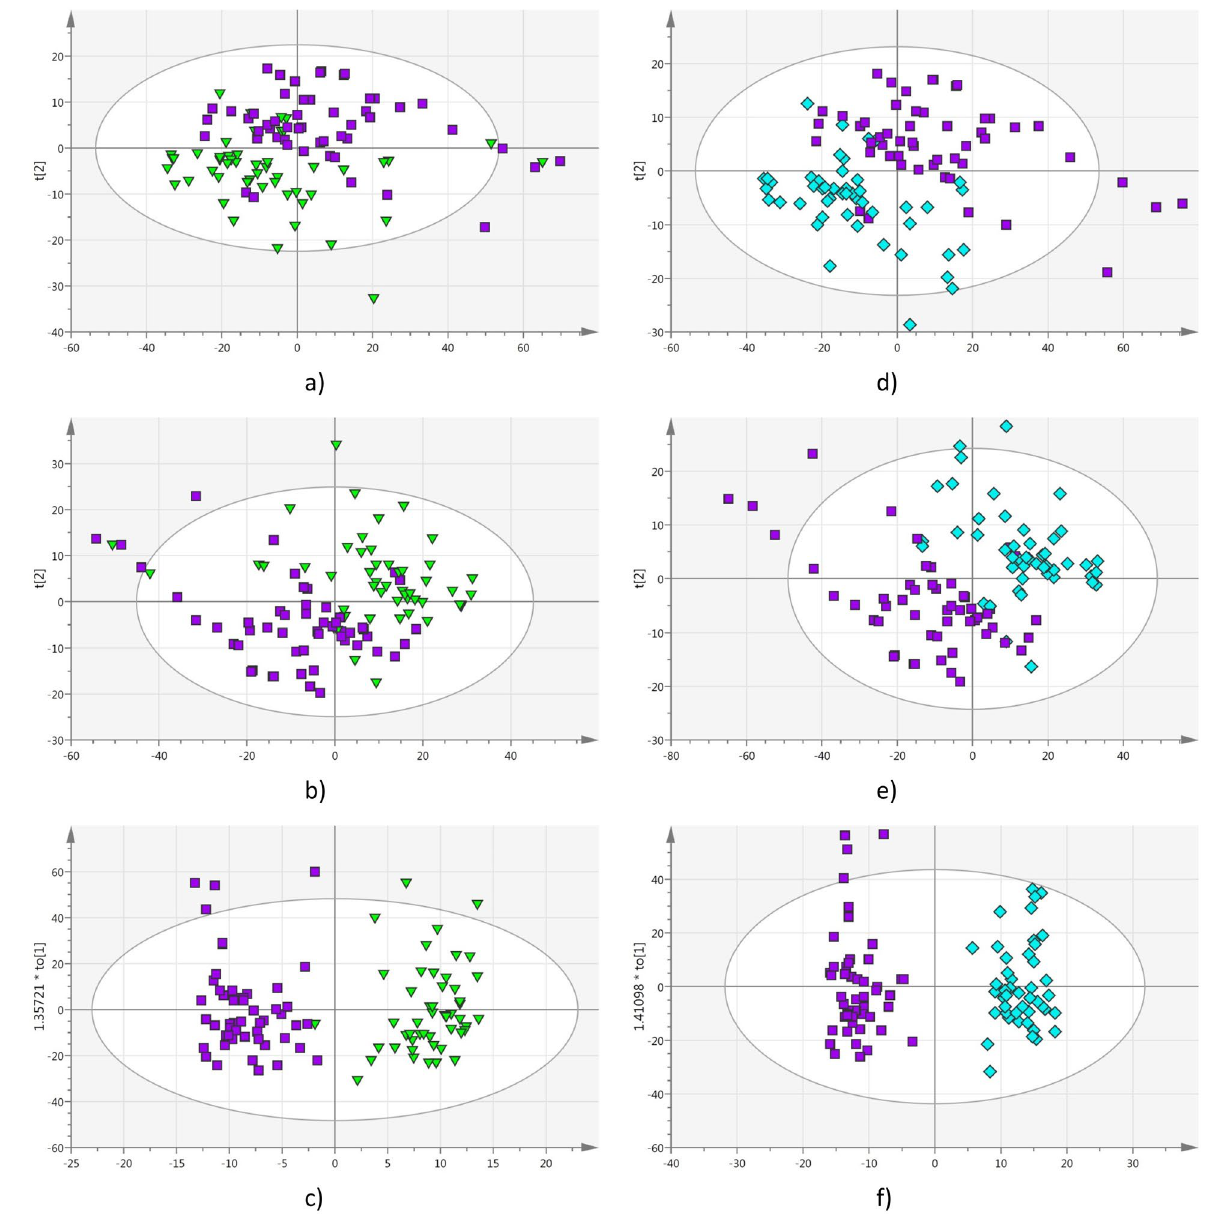
Figure 3. ( a ) PCA Scores plot; ( b ) PLS-DA Scores plot; ( c ) OPLS-DA Scores plot; analysis comparing UV–Vis spectra of pomegranate juices (squares) to those of 30% (inverted triangles) mixtures. ( d ) PCA Scores plot; ( e ) PLS-DA Scores plot; ( f ) OPLS-DA Scores plot; analysis comparing UV–Vis spectra of pomegranate juices (squares) to those of 40% (diamonds) mixtures.